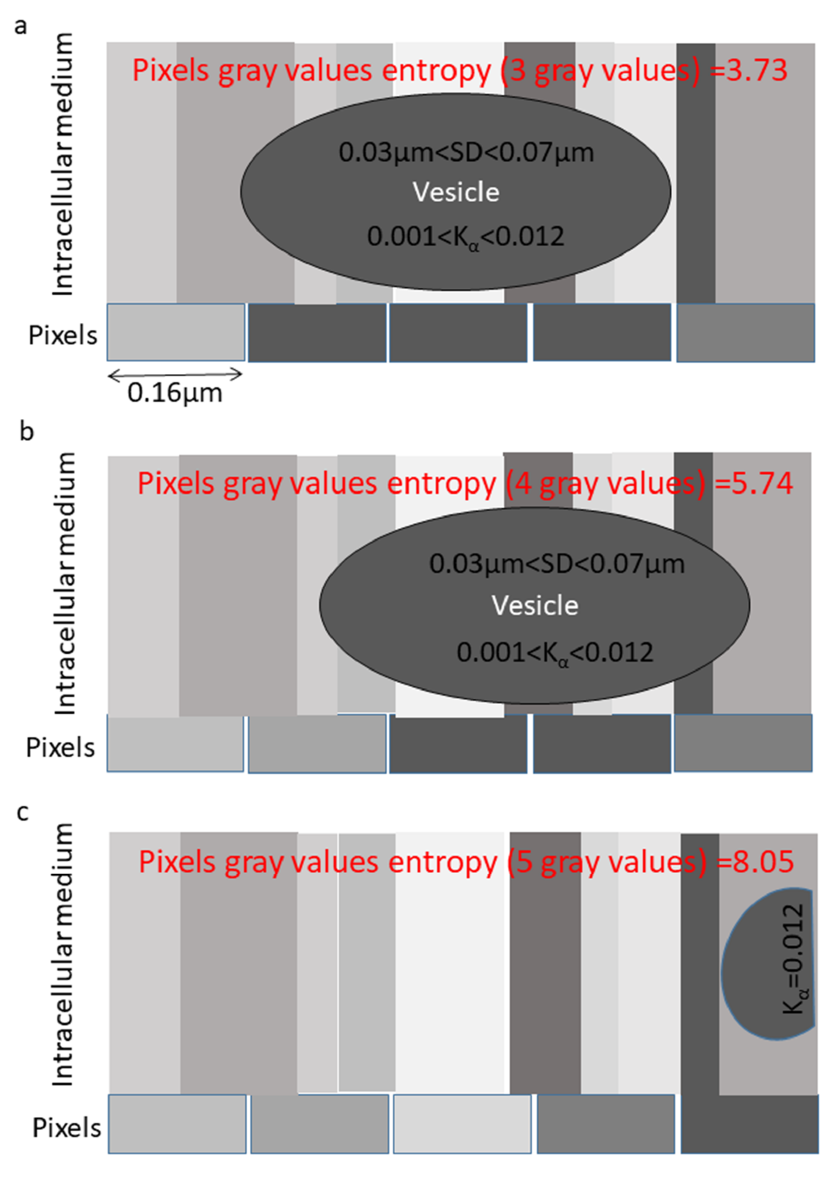
Figure 2. An example of a particle motion captured by five pixels in a non-homogenous intracellular medium. Parameters that match live cells experiments are presented: The pixel’s length is 0.16 µ m, and the di ff usion coe ffi cient of the vesicle is between 0.001 and 0.012 µ m 2 / s α (depending on the presence or absence of intracellular ATP), and accordingly the SD of length of translocations for a single time lag is between 0.03 and 0.07 µ m. ( a ) The particle is located in the center and covers the length of the three central pixels. Accordingly, the five pixels present three gray levels and information entropy of 3.73. ( b ) The particle moves a length of 0.5 pixel to the right. In that situation, it fully covers the length of two pixels, partially covers the length of two pixels and does not cover one pixel. Accordingly, the five pixels present four gray levels and information entropy of 5.74. ( c ) The particle conducts a large non-equilibrium translocation to the right. In that situation, it partially covers the last pixel. In that case, the five pixels present five di ff erent gray levels and information entropy of